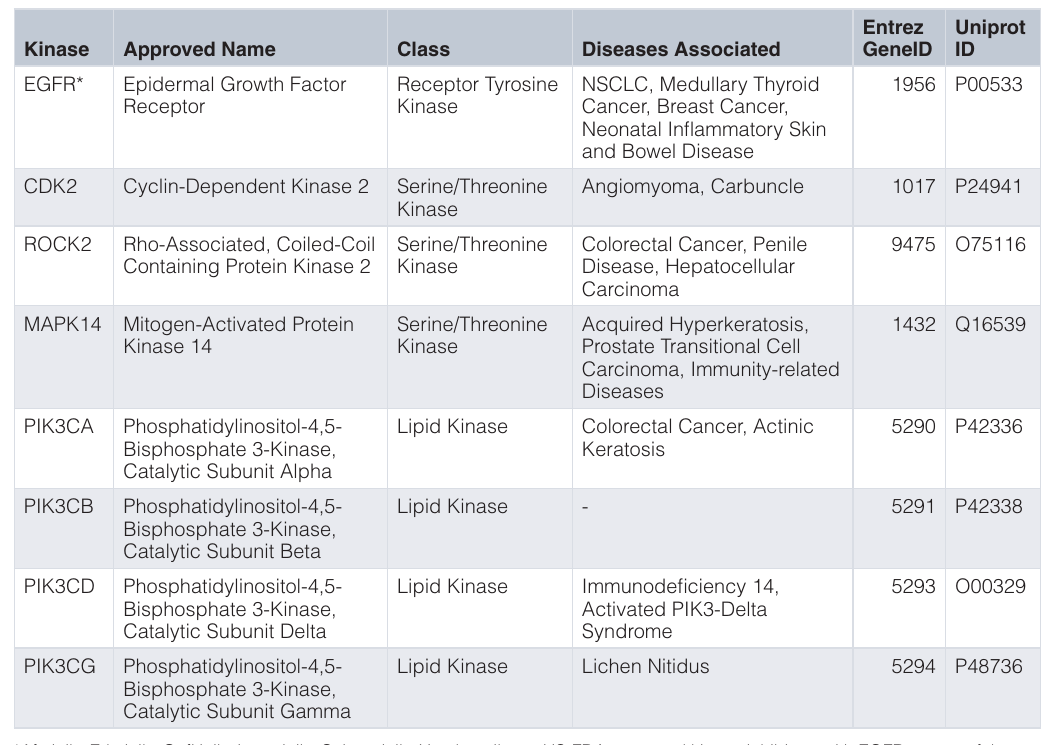
Table 4. Important aspects about the selected